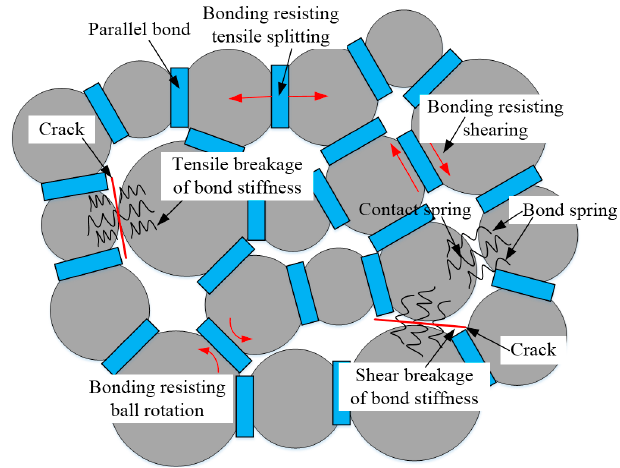
Figure 2. The parallel bond and its breaks of inter-particle bond in SRM [32].